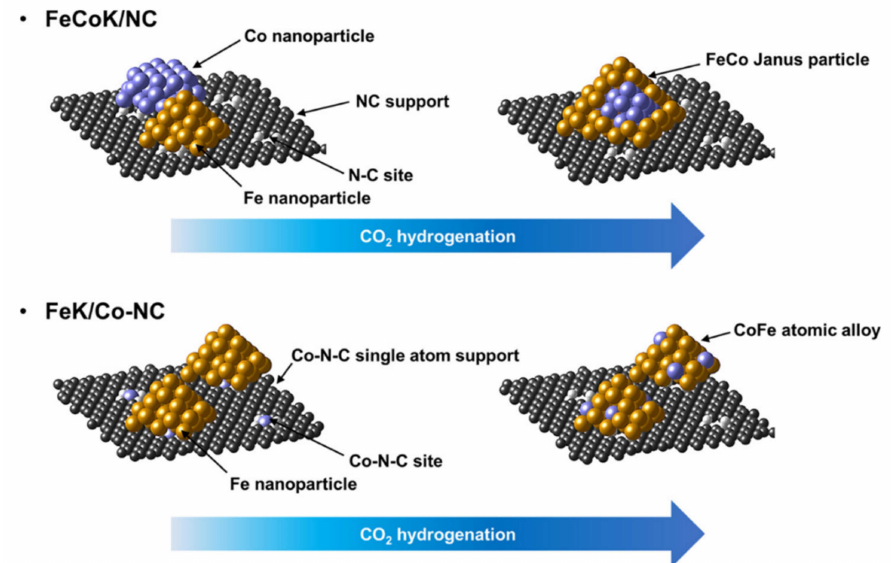
Figure 3. Proposed structures of the FeCoK/NC and FeK/Co-NC catalysts after CO 2 hydrogenation Reprinted with permission from Hwang et al. [36]. Copyright (2021) American Chemical